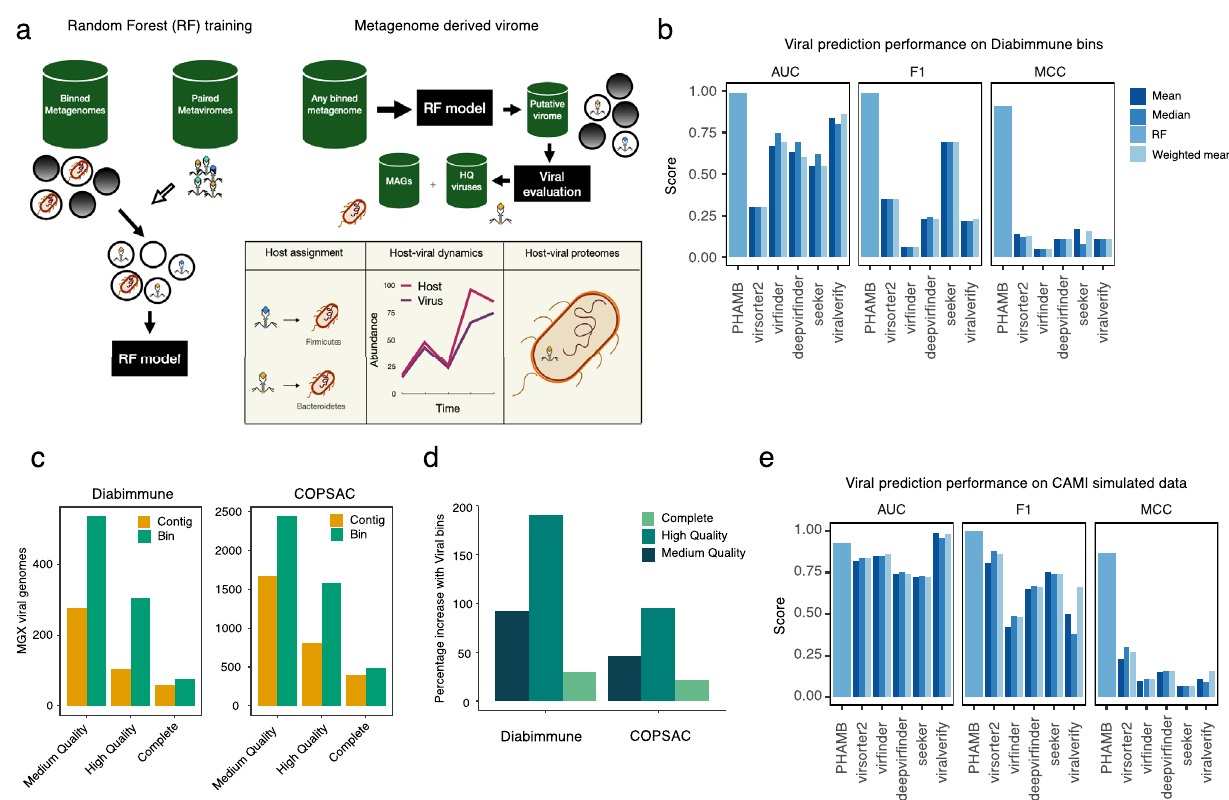
Fig. 1 A framework to bin and assemble viral populations from metagenomics data. a Illustration of work fl ow to explore viruses from binned metagenomes. First, the RF model was trained on binned metagenomes; bacterial bins were identi fi ed using reference database tools and viruses were identi fi ed using assembled viruses from paired metaviromes. Viral and bacterial labelled bins were used as input for training and evaluating the RF model. Bins from any metagenome such as human gut, soil or marine can be parsed through the RF model to extract a space of putative viral bins that are further validated for HQ viruses using dedicated tools like CheckV. Binned MAGs and viruses can then be associated in a host assignment step. Host-viral dynamics can be explored in longitudinal datasets to establish temperate phages and the contribution of viruses to Host pangenomes b AUC, F1-score and Matthews correlation were calculated for prediction results on viral bins from Diabimmune. These performance scores were calculated based on probability scores from the trained RF model and summarised viral bin-scores of various viral prediction tools. For all tools except the RF model, genomes were labelled viral if the summarised viral score across all contigs, calculated either as a mean, median or contig-length weighted mean passed a threshold. The following thresholds used were 7, 0.5, 0.9, 0.9, 0.9 for viralVerify, Seeker, Virsorter2, Vir fi nder and DeepVir fi nder, respectively. c The number of viral genomes recovered from bulk metagenomes, counted at three different levels of completeness in Diabimmune or COPSAC cohorts, evaluated as either single-contigs or viral bins from bulk metagenomes. Evaluation of genome completeness was determined using CheckV here shown for MQ ≥ 50%, HQ ≥ 90%, Complete = Closed genomes based on direct terminal repeats (DTR) or inverted terminal repeats. d The percentage-increase of viral genomes found in Diabimmune or COPSAC cohorts using our approach relative to single-contig evaluation. The increase is coloured at three different levels of completeness determined using CheckV, corresponding to the ones used in ( c ). e Similar to ( b ) prediction performance scores were calculated for the trained RF model and various viral predictors but on prediction results of CAMI simulated viral genomes from the mixed genome set including bacteria, viruses and plasmids. MAGs metagenome-assembled genomes, HQ high-quality, MQ medium-quality and AUC area under